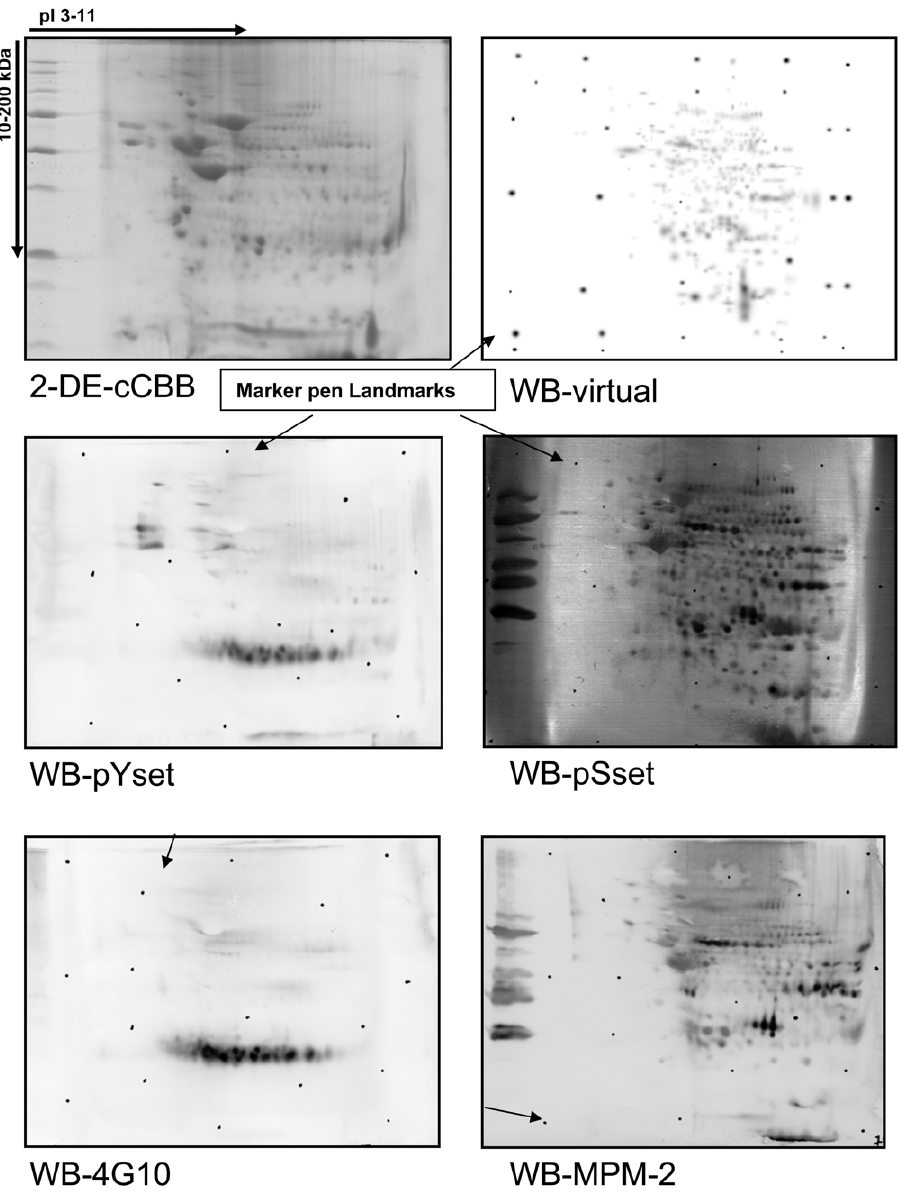
Figure 2. 2-DE maps. 200 m g of tissue lysate protein extracts were separated on 2-DE and stained with Colloidal Coomassie G-250 and acquired as an image (2-DE-cCBB). In parallel 40 m g of total protein extract was separated by 2-DE and subsequently transferred onto PVDF membrane for incubation with antibodies directed against phosphorylated proteins. With a marker pen, landmarks points (some are highlighted by arrows in the Figure) were set around the membrane to be used for computer assisted merging and matching of images of phosphorylated proteins as acquired with the Abs WB-Yset, WB-pSset, WB-4G10, WB-MPM-2. Subsequently, protein spots on the same membrane were revealed by cCCB-post staining and the image was recorded (not shown). Using the marker added landmarks, the images were superimposed and combined by the image analysis software to create a virtual image showing the phosphoproteins and the total proteins together (WB-virtual).